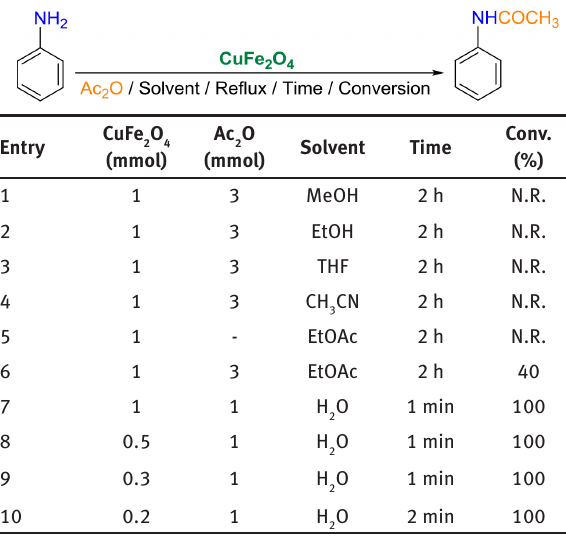
N.R. = No reaction (Conv. = 0)